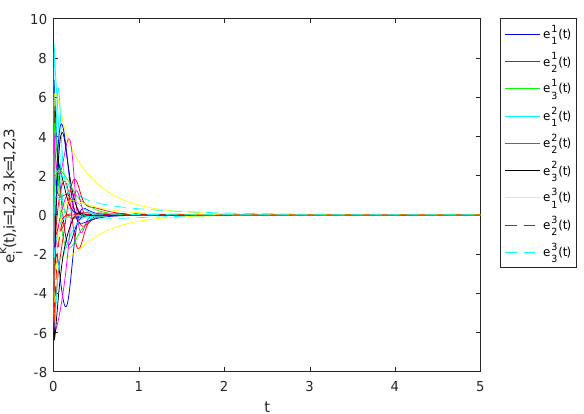
Figure 11. Trajectories of x